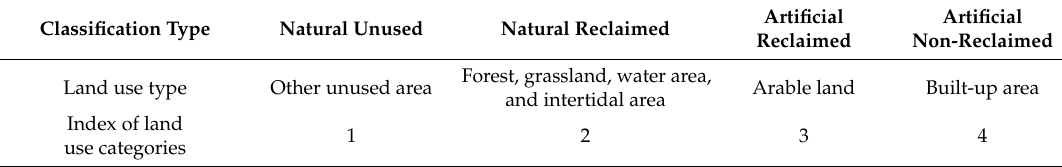
Table 2. Classification and index of land use